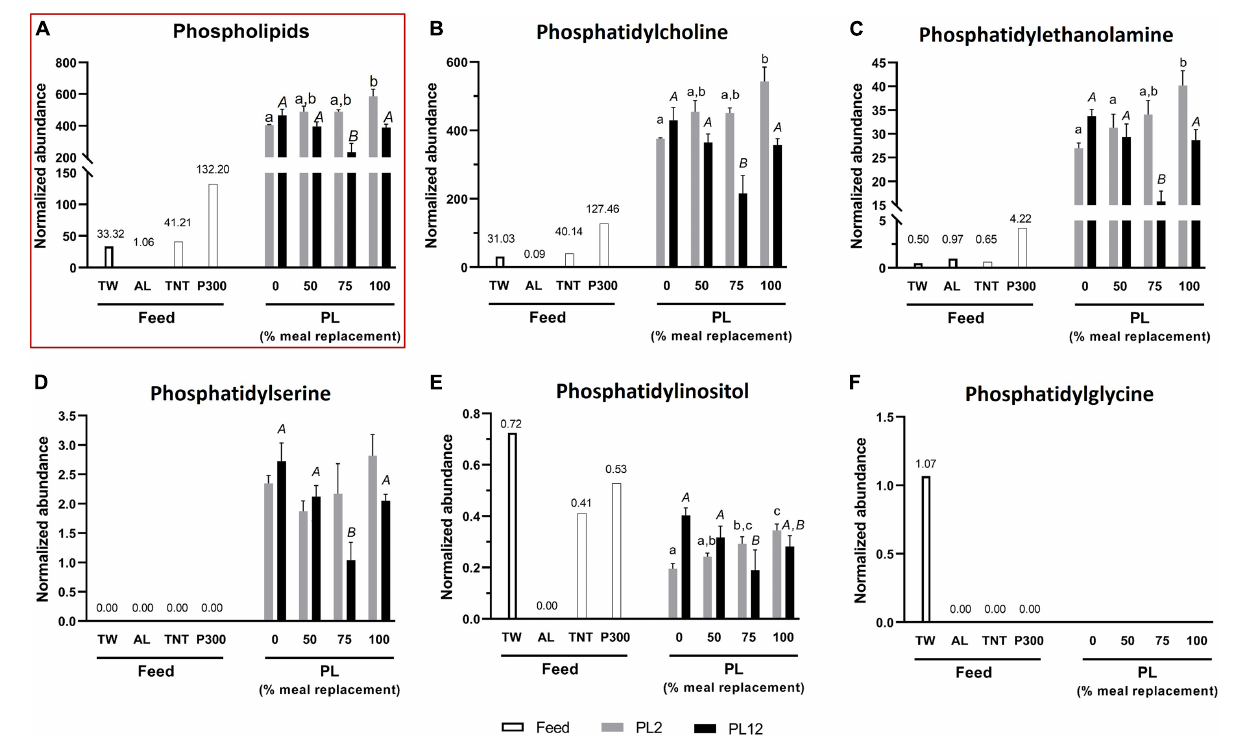
FIGURE 2 | Analysis of phospholipids in feed and PL shrimp by LC-HRMS. Percent of meal replacement was percent of the number of meals for which TW was replaced by AL. Normalized abundance was derived from the peak intensity value normalized to that of tributyrin, the internal standard. Error bars represent standard errors ( N = 3). Statistical analyses of the PL2 and PL12 data sets were performed separately, using ANOVA. Significant differences among subsets of treatment groups were determined by Duncan’s multiple range test ( P < 0.05); subsets with means not significantly different from one another are identified with the same letter above the bar. Small- and big-capital letters are individually for the PL2 and PL12 data sets, respectively. Bars with no specified letters mean no significant differences were identified among the groups ( P >